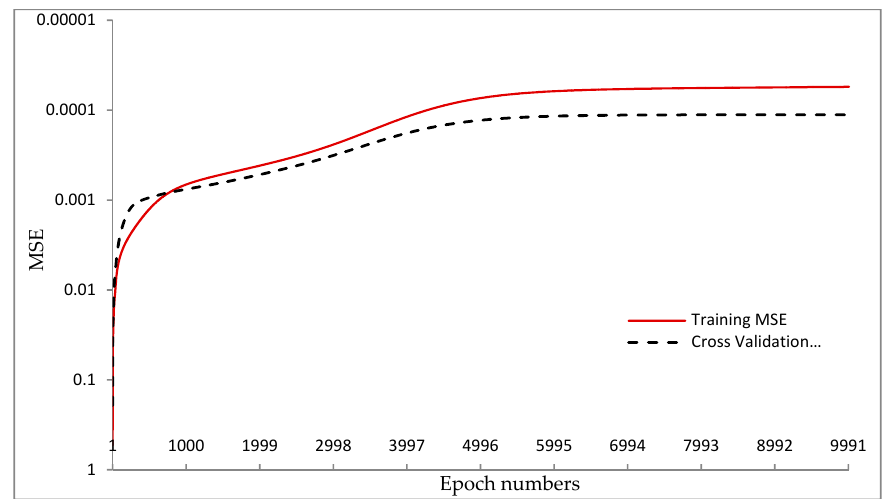
Figure 12. The testing of the MSE for the proposed SOFM model using 10,000 epochs.